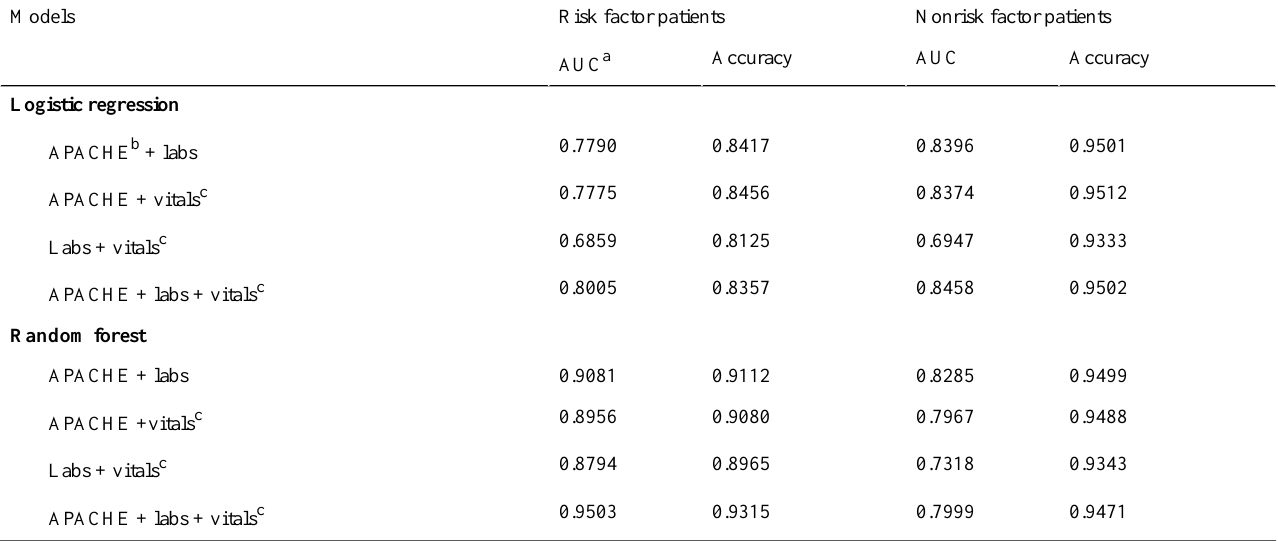
Table 4. Heart failure prediction accuracy and AUC.